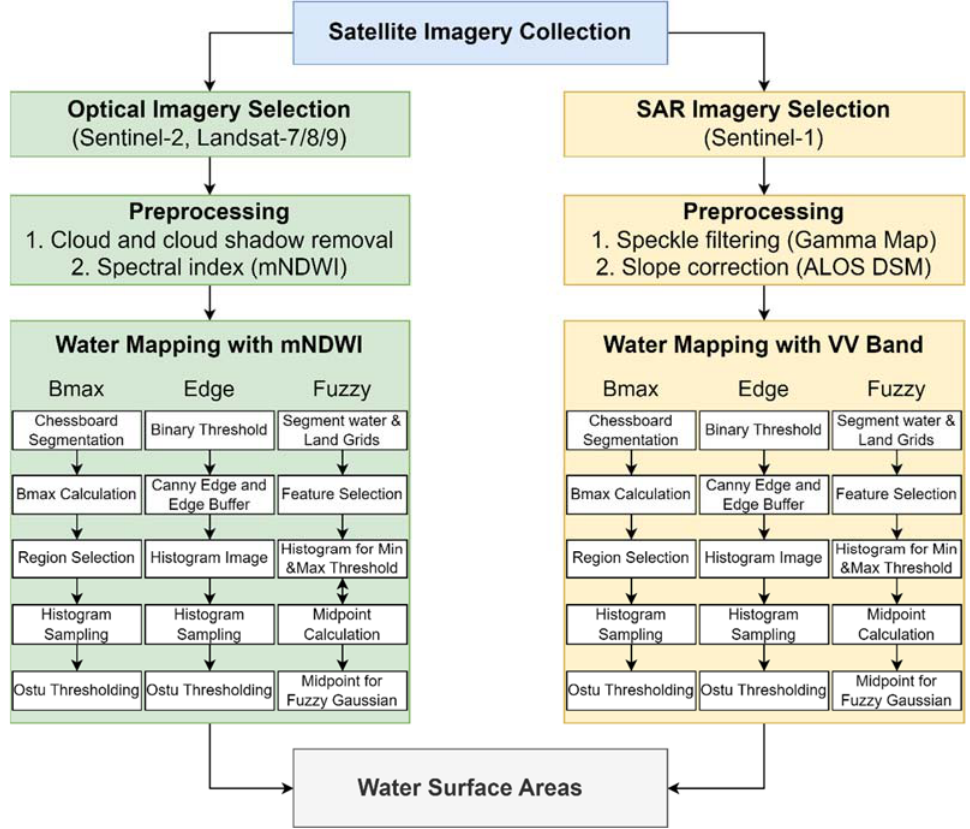
Figure 4. The workflow of automated satellite ‐ based surface water mapping.